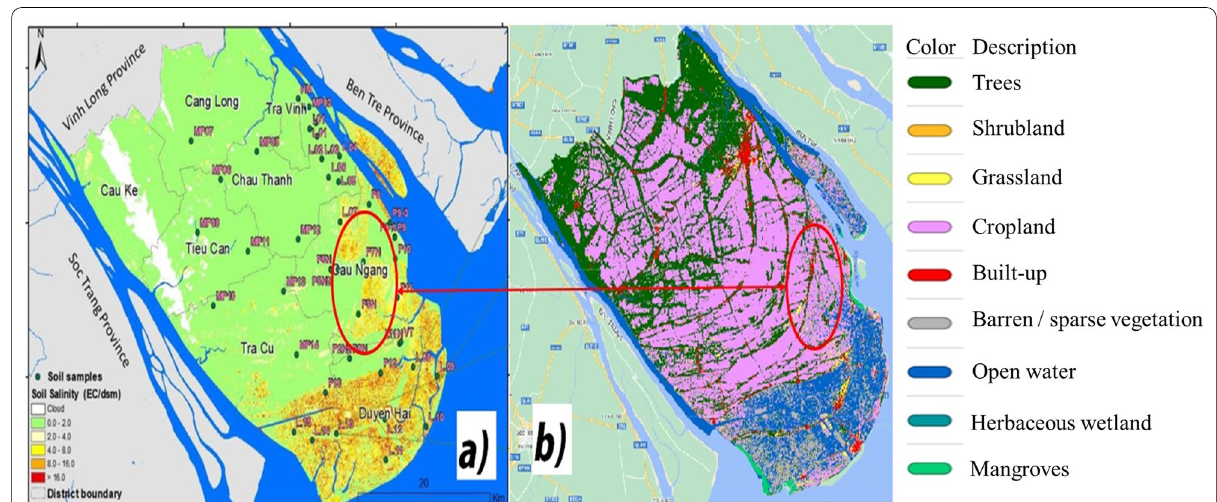
Fig. 1 Comparison of soil salinity map ( a ) created by Nguyen et al. (2020) and land cover map derived from the ESA ( b ). The land cover map was derived from the European Space Agency (ESA) World Cover with a spatial resolution of 10 m